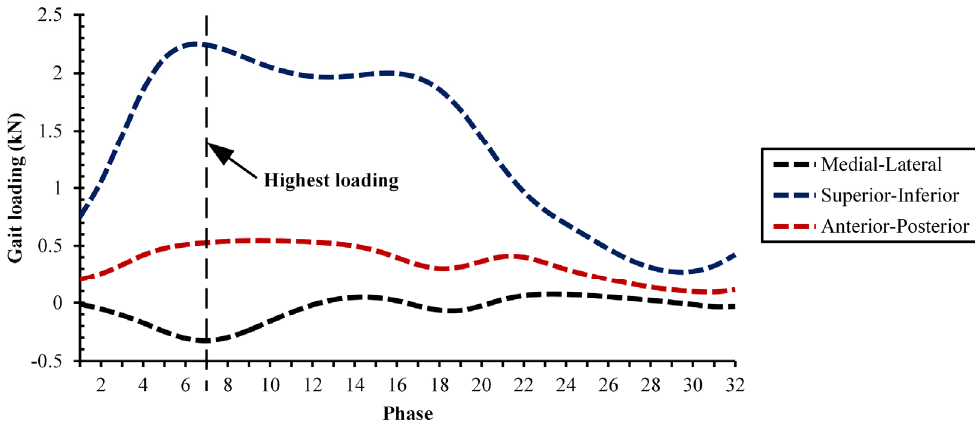
Figure 3. Triaxial forces during gait loading [24].